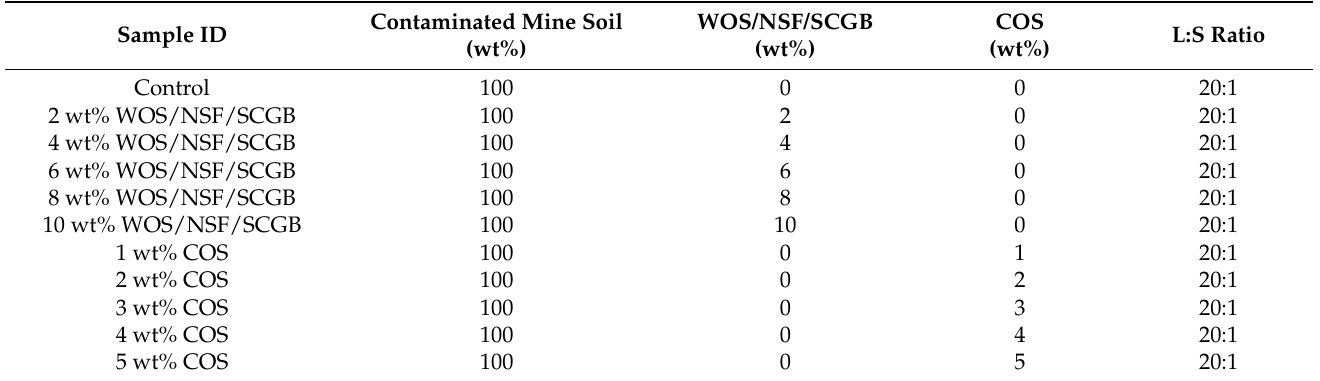
Table 3. Treatability matrix for Pb-contaminated mine